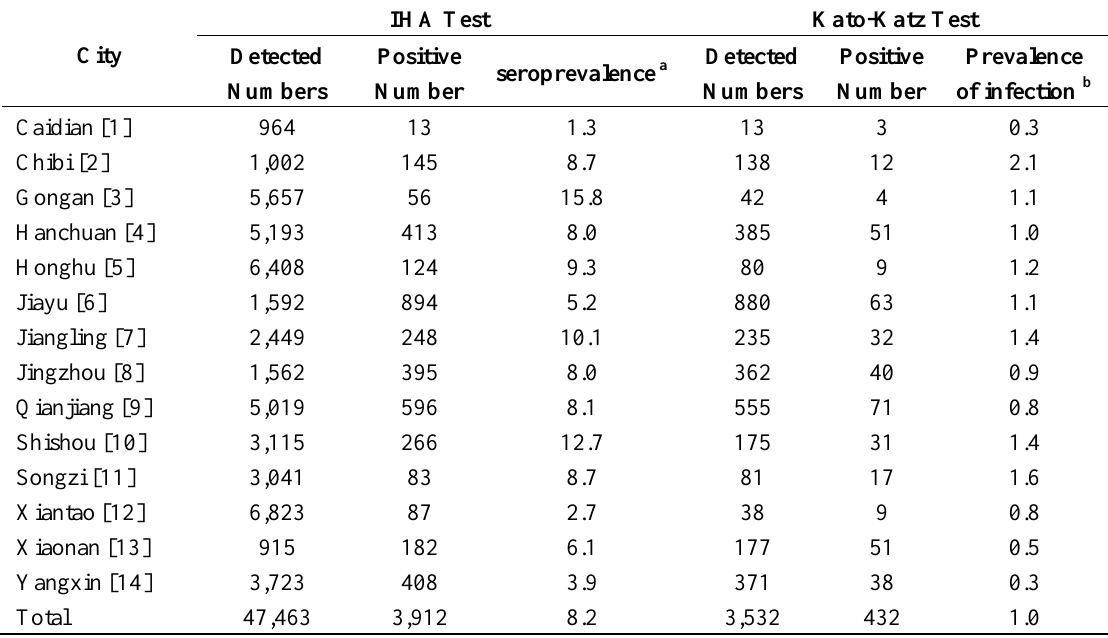
Table 2. Prevalence of 14 cities by diagnosis of IHA and Kato-Katz in the survey of S. japonica in Hubei Province, China, 2011.